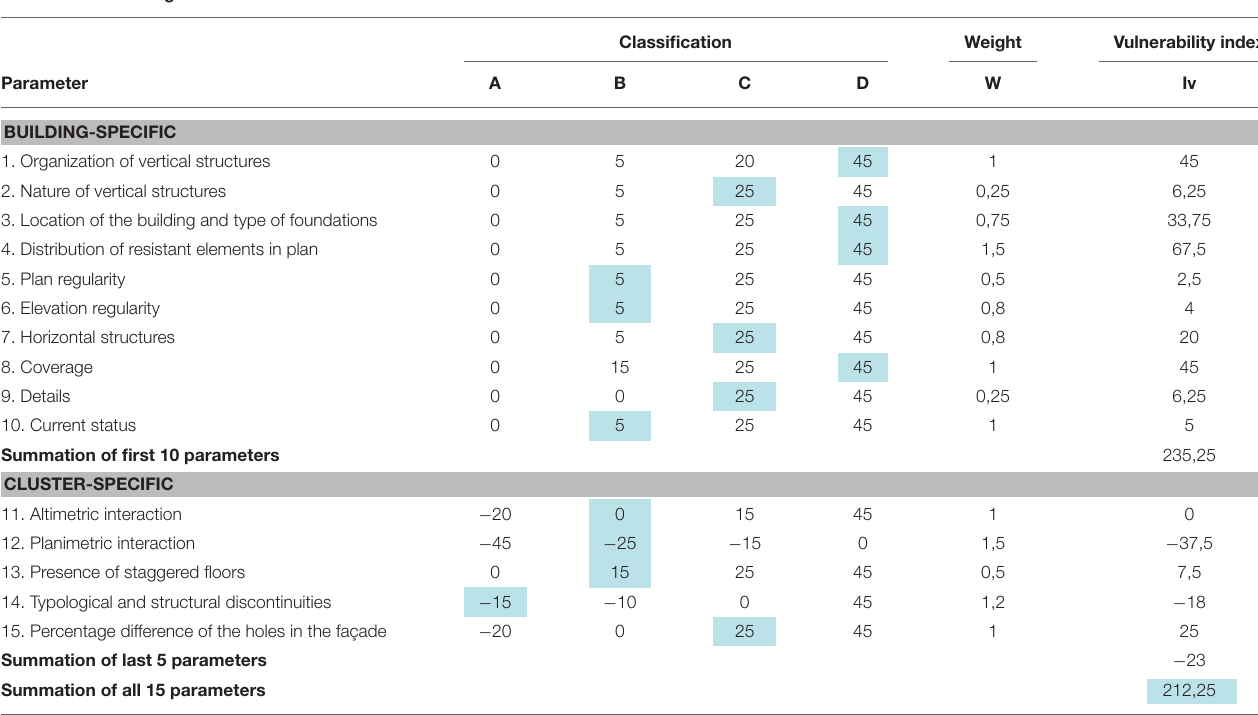
TABLE 2 | Quick form based vulnerability index of the S.U. type